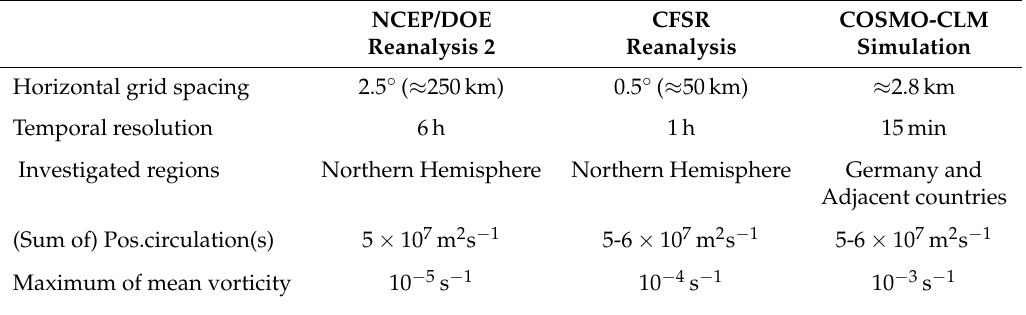
Table 1. Summary of the data used to study Kyrill and the properties identified with the help of the W k -method. In the two higher resolved datasets, CFSR and COSMO, the sum of positive circulations was calculated inside the effective radius of Kyrill. This radius was derived from the NCEP data. The circulation and mean vorticity values are given for the 850-hPa level for the most intense periods of